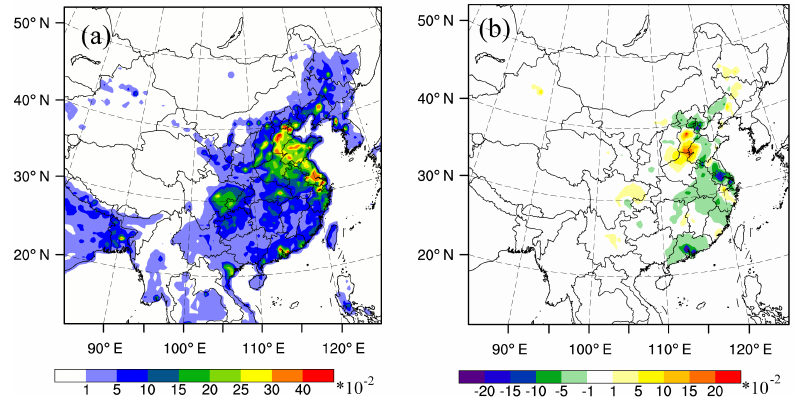
Figure 8. Spatial distribution of (a) the prior unspeciated primary sources of PM 2 . 5 (µgm − 2 s − 1 ) and (b) the time-averaged differences between the ensemble mean analysis and the prior values (µgm − 2 s − 1 ) at the lowest model level averaged over all hours from 6 to 16 Octo- ber